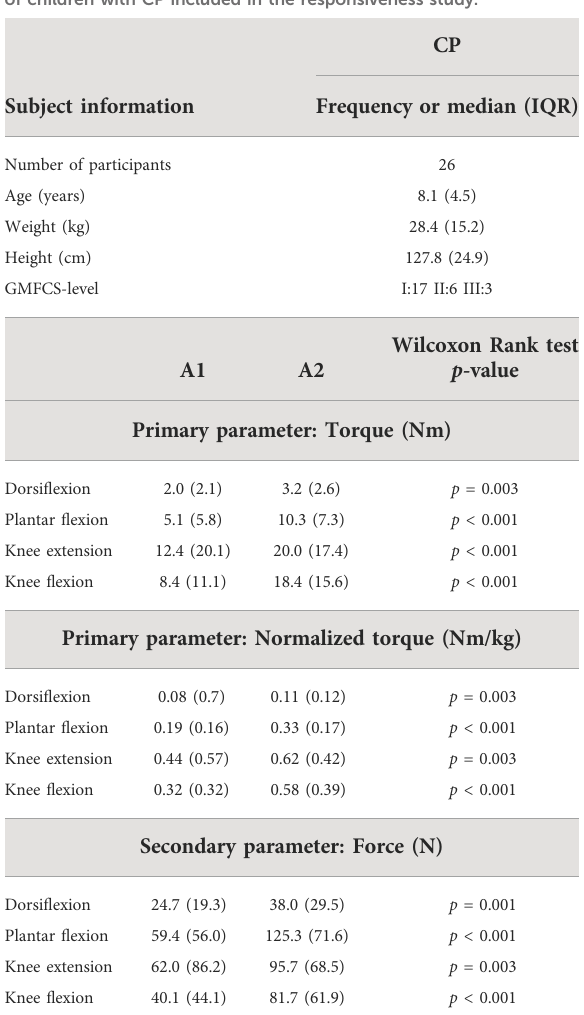
TABLE 5Subject characteristics, median MVICs ofthe fi rst andsecond assessment and statistical results after the strength intervention of children with CP included in the responsiveness